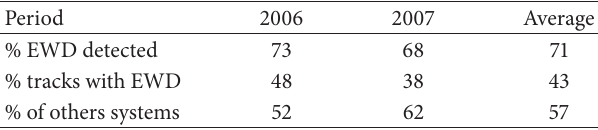
Table 2: Percentage of EWDs detected by TracKH, EWDs tracks, and other systems cyclonic vorticity centre